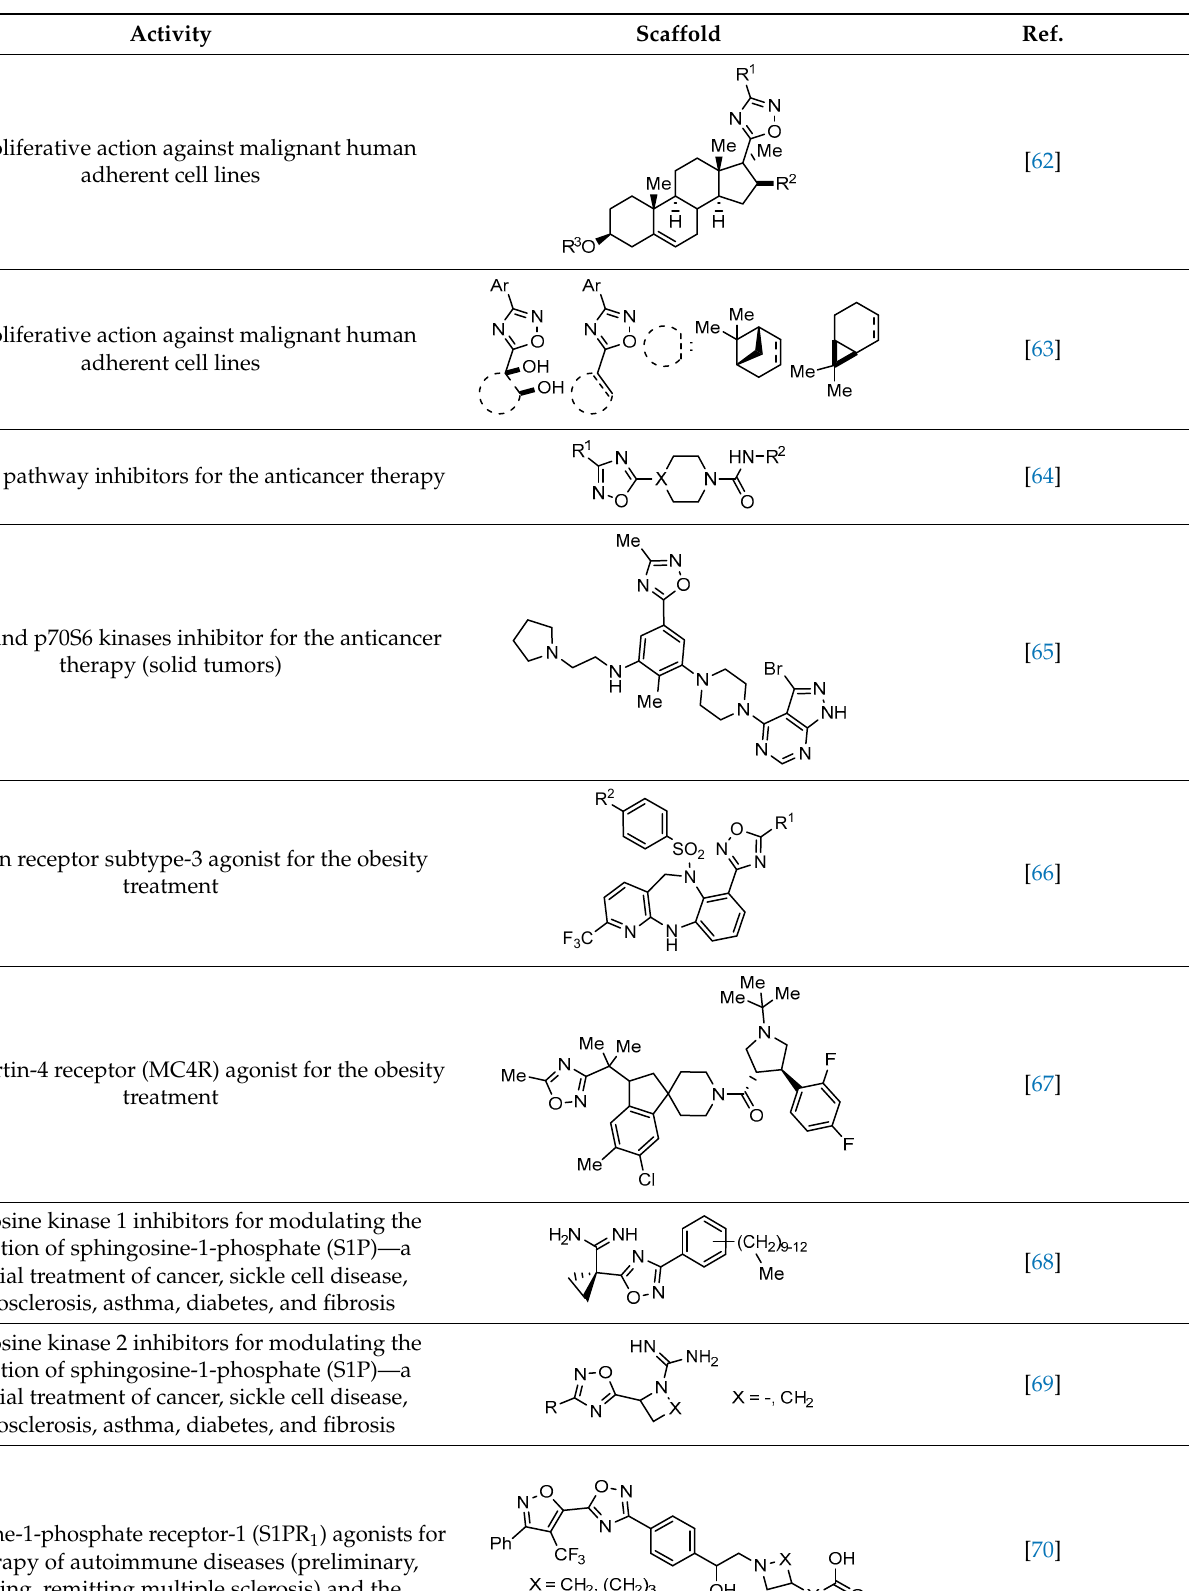
Table 1. Cont. Activity